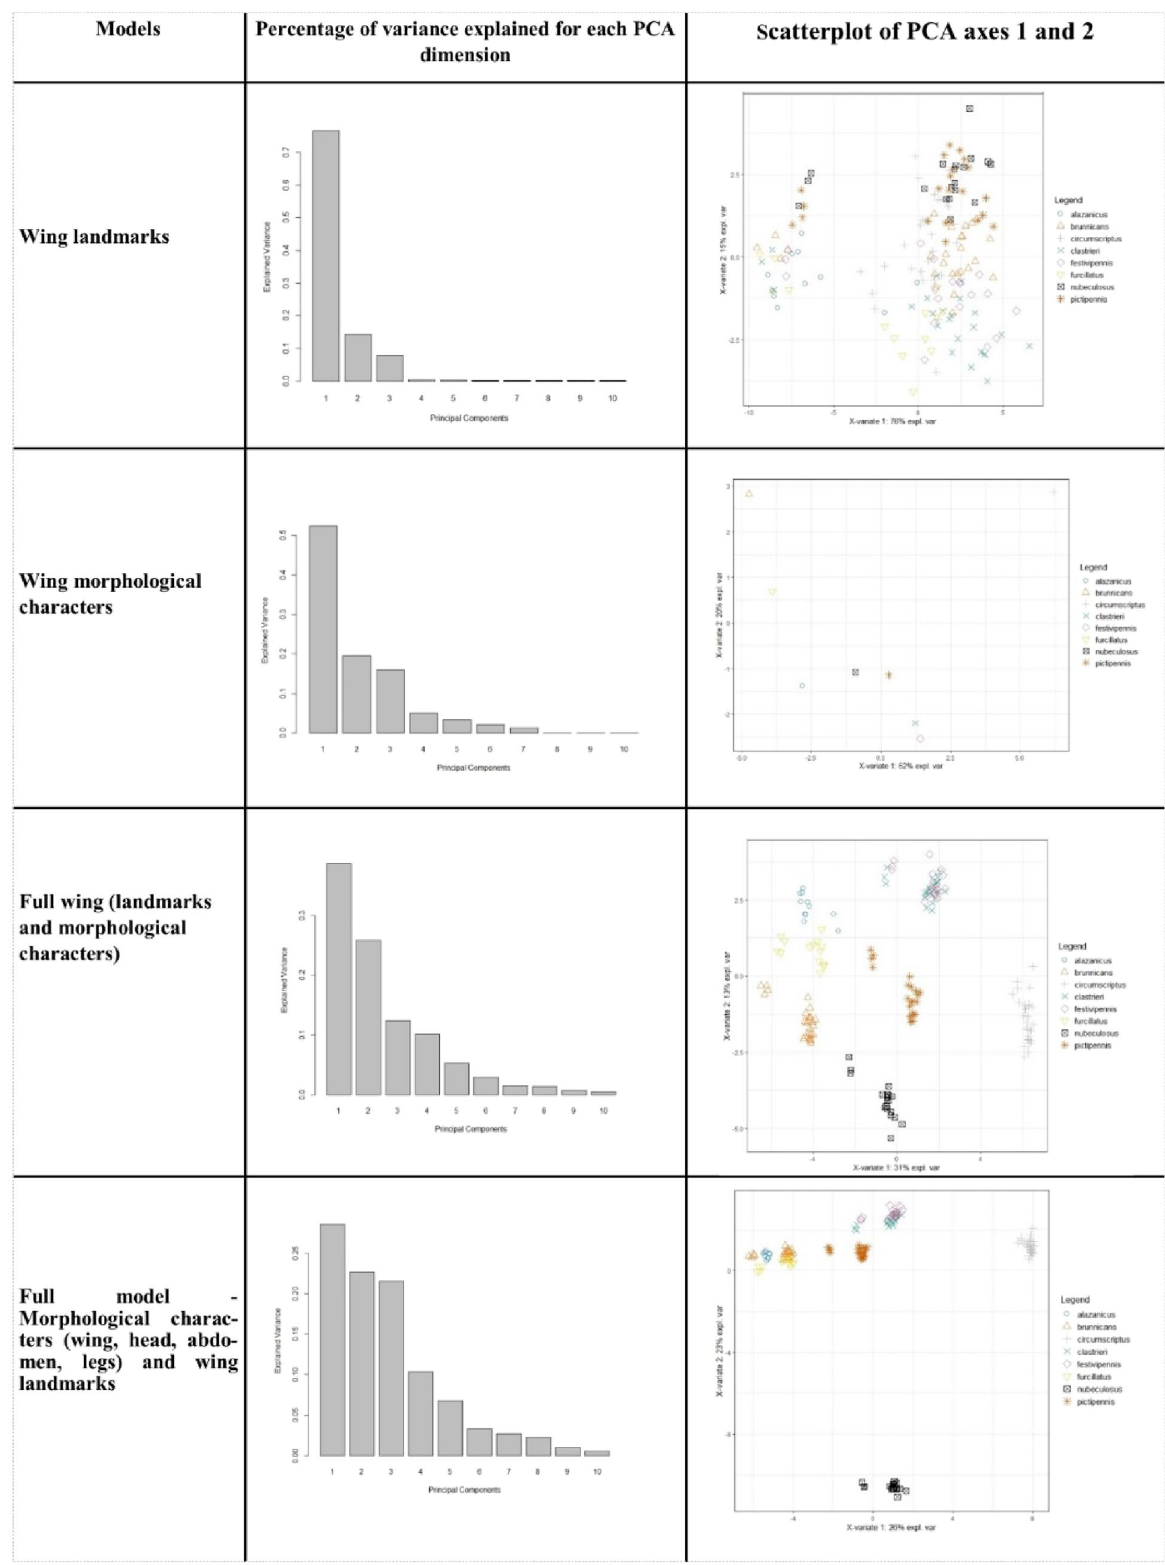
Figure 3. Principal component analysis (PCA): percentage of variance explained for each PCA dimension and